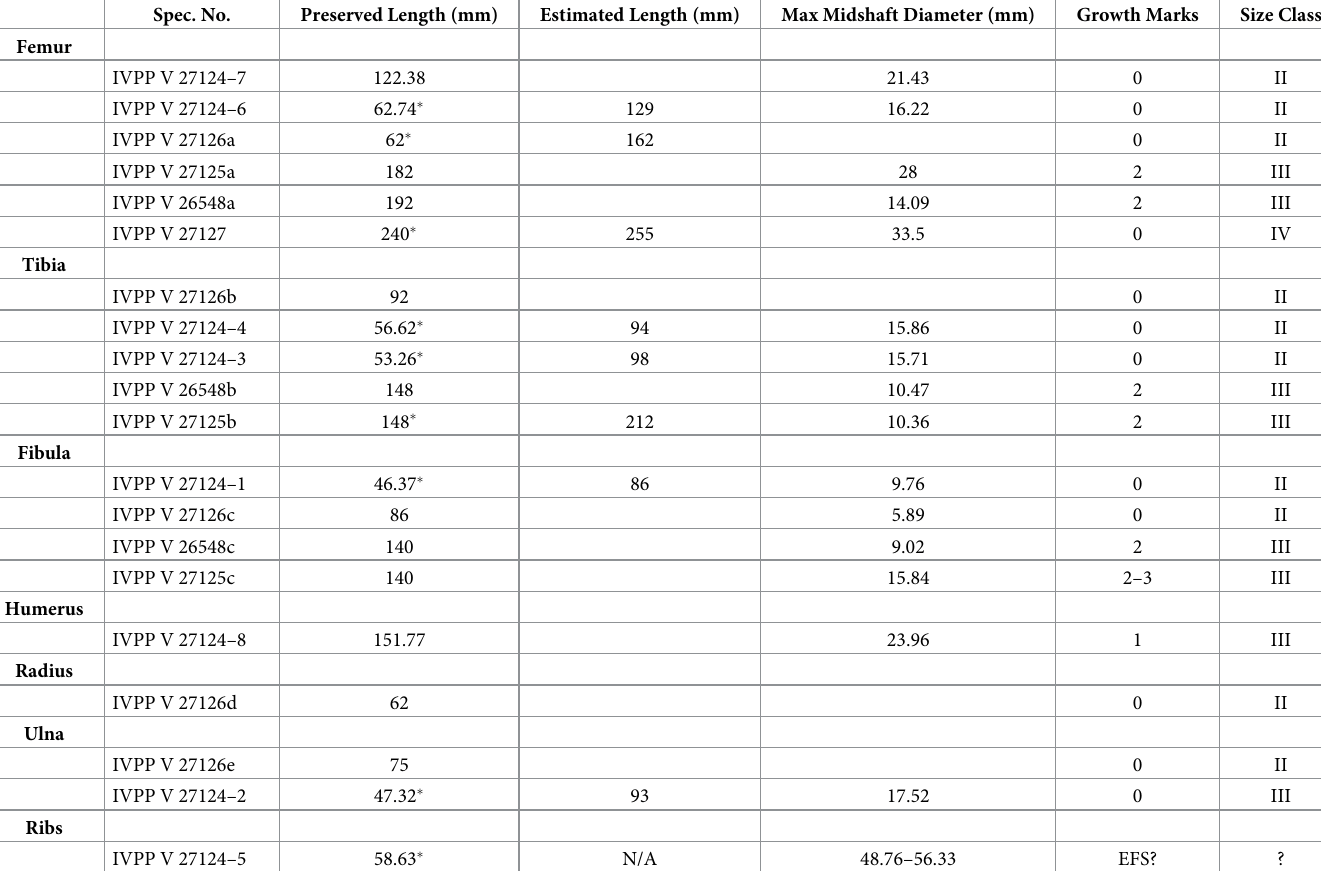
Table 1. Postcranial element length and maximum midshaft diameter for the twenty skeletal elements of Lystrosaurus sp. from the Jiucaiyuan Formation that were histologically sampled. Asterisk indicates fragmentary or incomplete specimens with accompanying estimates based on complete specimens in this dataset. Spec. No. Preserved Length (mm) Estimated Length (mm) Max Midshaft Diameter (mm) Growth Marks Size Class